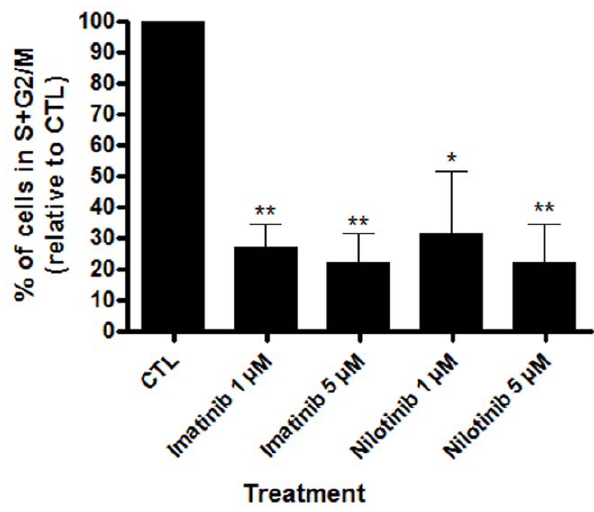
Figure 4. Colony formation in presence of tyrosine kinase inhibitors were decreased due to the inhibition of cell cycle entry. Human cord blood CD34 + were cultured for 48 hours in presence/absence of either imatinib or nilotinib and then stained with propidium iodide using the CycleTEST TM Plus DNA Reagent Kit. Results are expressed as mean percentages relative to control experiments without TKIs 6 SD. n=3, *p , 0.05, **p , 0.01 versus CTL, Student’s paired t tests. CTL: control condition without